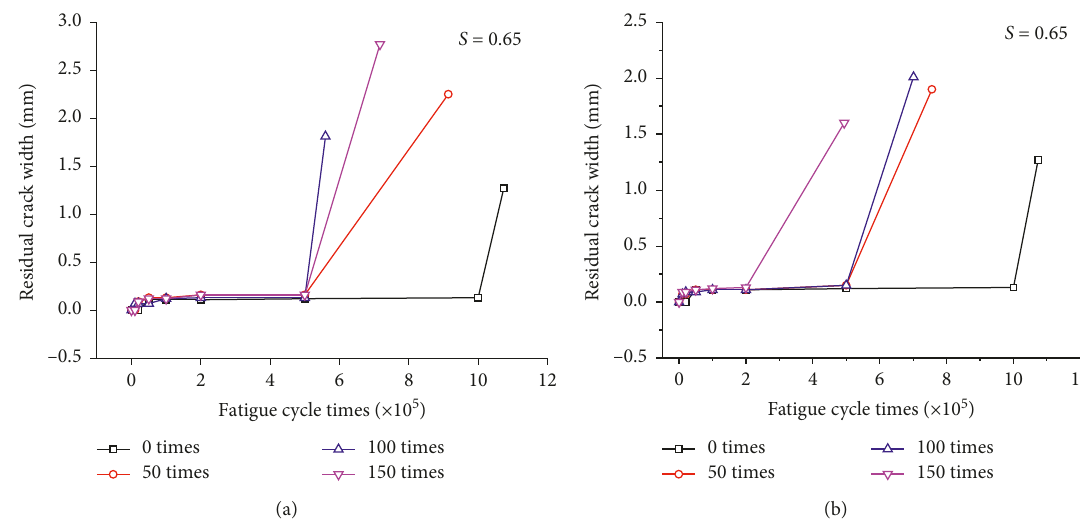
Figure 9: Residual crack width diagram. (a) Water-frozen specimen. (b) Salt-frozen specimen.